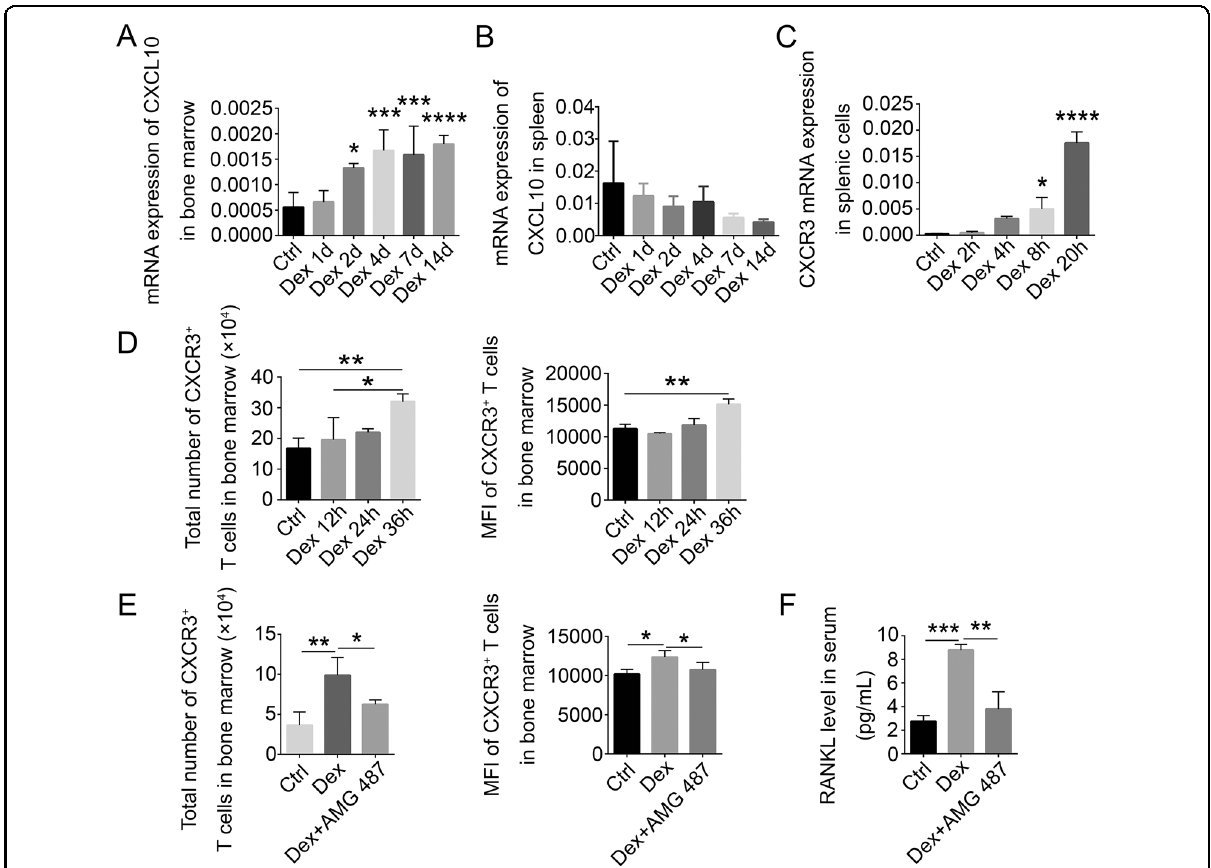
Fig. 7 Chemokines drive the accumulation of T cells in bone marrow. CXCL10 mRNA levels relative to beta-actin in bone marrow ( A ) and spleen ( B ) from WT mice treated with Dex for the indicated times, as measured by Q-PCR ( n = 5). C CXCR3 mRNA levels (relative to beta-actin) in splenic T cells from WT mice treated with Dex for the indicated times ( n = 5). D The total number of CXCR3-expressing cells and median fl uorescence intensity of CXCR3 in bone marrow T cells from WT mice treated with Dex for the indicated times, as measured by fl ow cytometry ( n = 5). E The total number of CXCR3-expressing cells and median fl uorescence intensity of CXCR3 in bone marrow T cells from WT mice treated with or without Dex, with or without injection of CXCR3 antagonist (5 mg/kg daily, for 3 days) ( n = 5). F RANKL protein levels in serum from WT mice treated as in ( E ) ( n = 4). Bars represent mean ±